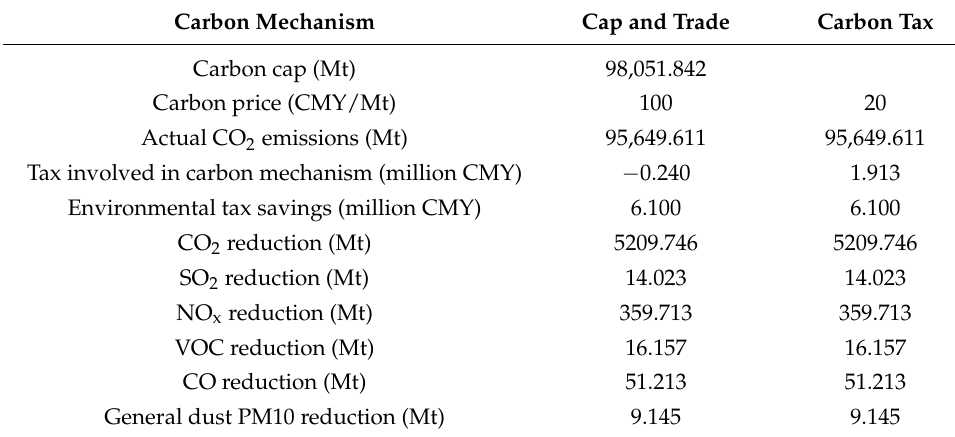
Table 5. Comparison of the impact of carbon price on environmental benefits to all parties under the two carbon